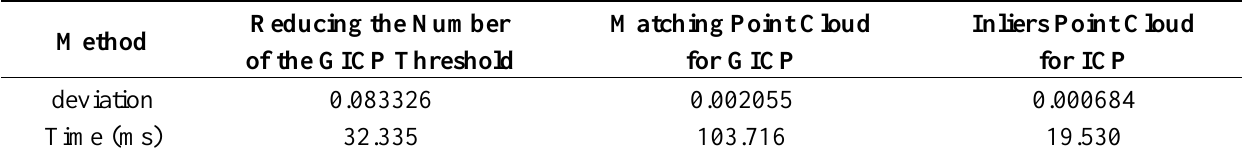
Table 1. Different results for Insufficient number of processing method in Freiburg